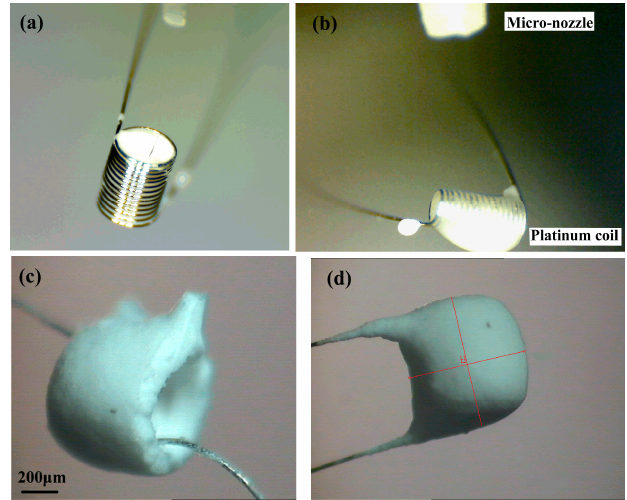
Figure 7. Pellistors: ( a ) filled with suspension, ( b ) with suspension on external surface, ( c ) with defects of shrinkage cavity, and ( d ) with perfect Carrier.